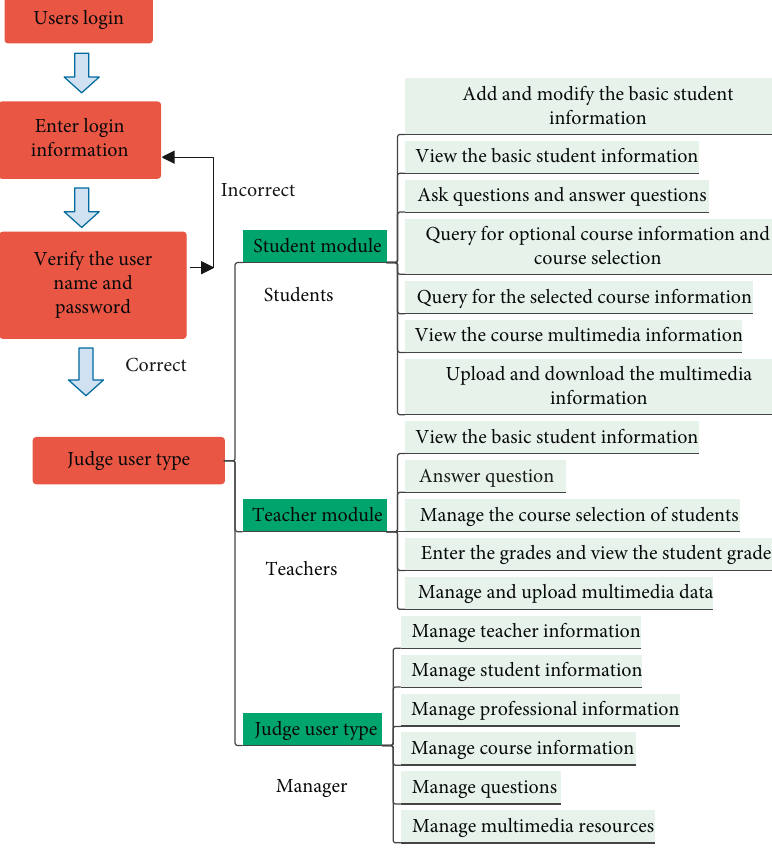
Figure 5: Flowchart of the network-interactive English teaching platform.